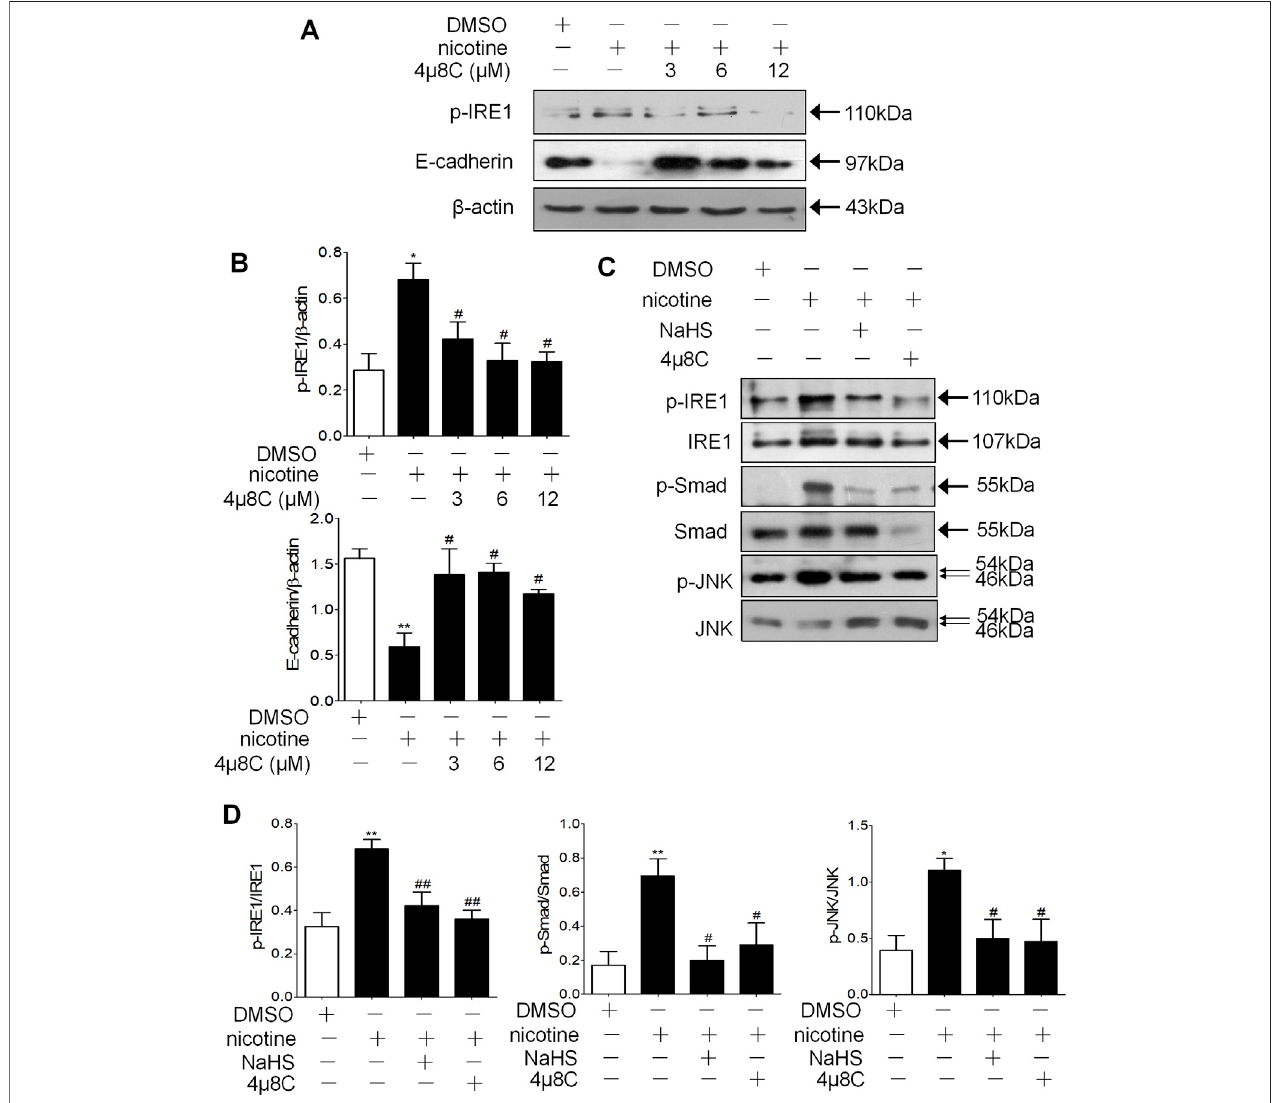
FIGURE 7 | NaHS and IRE1 activation inhibitor 4 μ 8C inhibited the phosphorylation of IRE1 and Smad2/3 to inhibit EMT in 16HBE cells. (A,B) Western blotting analysis of p-IRE1 and E-cadherin protein expression in 16HBE cells, and relative intensity normalized to the expression of β -actin ( n = 3, respectively, in each group). Values are expressed as mean ± SEM. * p < 0.05 vs. the DMSO group and # p < 0.05 vs. nicotine group. (C,D) Western blotting analysis of the ratio of p-IRE1/IRE1, p-Smad2/3/Smad2/3 and p-JNK/JNK in 16HBE cells. Results are presented from 3 independent experiments ( n = 3, respectively, in each group). Values are expressed as mean ± SEM. * p < 0.05, ** p < 0.01 vs. the DMSO group. # p < 0.05, ## p < 0.01 vs. nicotine